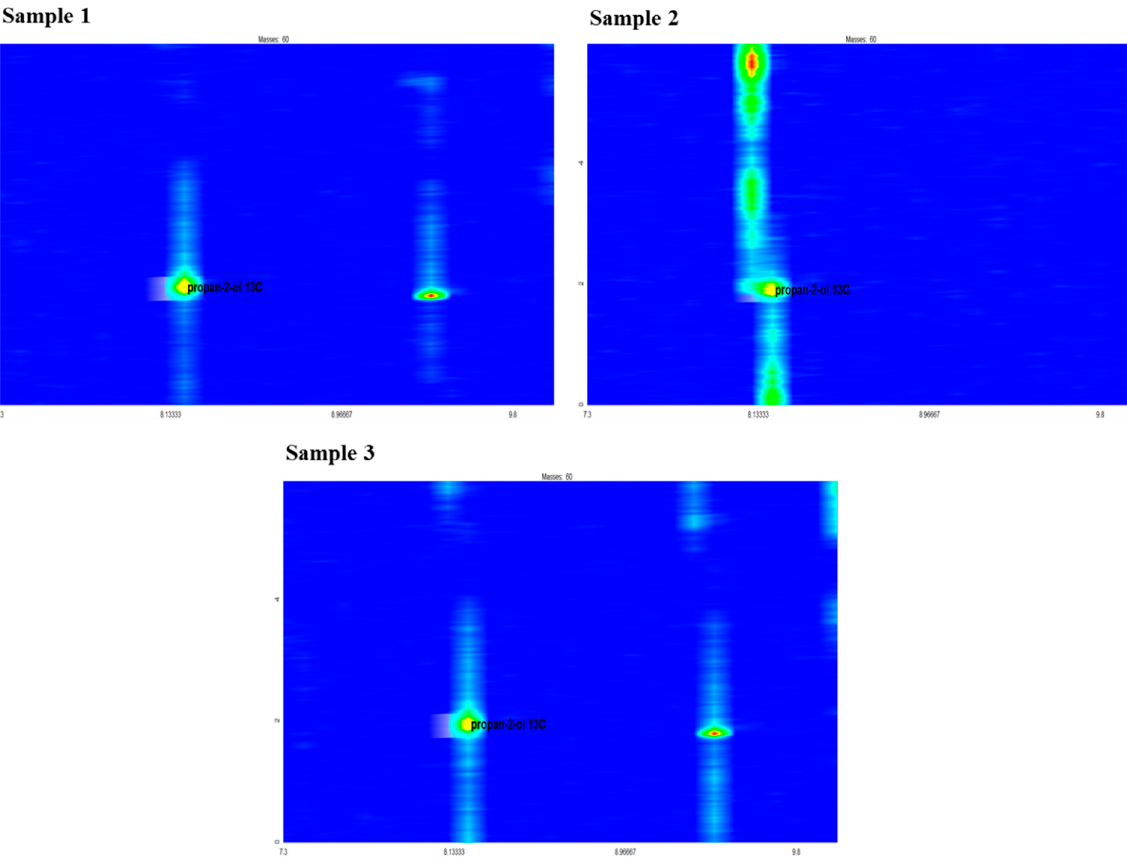
Figure 3. Results of comprehensive two-dimensional gas chromatography coupled with time of flight mass spectrometry (GC × GC-TOF MS) analysis of distillates. (Sample no. 1—distillate from mash inoculated with Saccharomyces cerevisiae yeast; Sample no. 2—distillate from mash inoculated with LAB; Sample no. 3—distillate from mash inoculated with S. cerevisiae yeast and LAB).